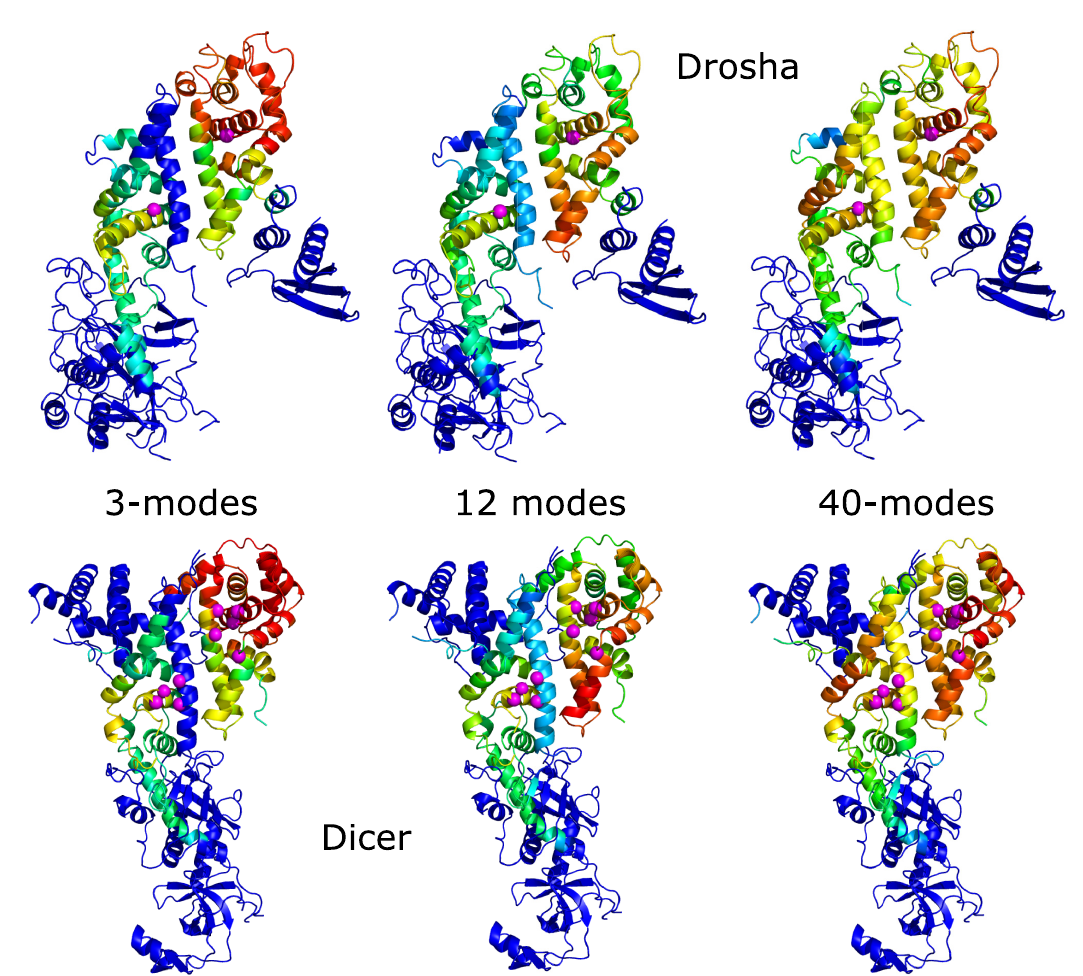
Fig 6. Local ANM modes alignment of Drosha and Dicer. Protein structures of Drosha (top) and Dicer (bottom) colored according to the RDSS calculated from local alignment of the three (left), twelve (middle), and forty (right) ANM slowest modes. Catalytic residues are represented as magenta spheres. Warm colors (high RDSS) represent high local dynamic similarity and cold colors (low RDSS) represent low dynamic similarity.